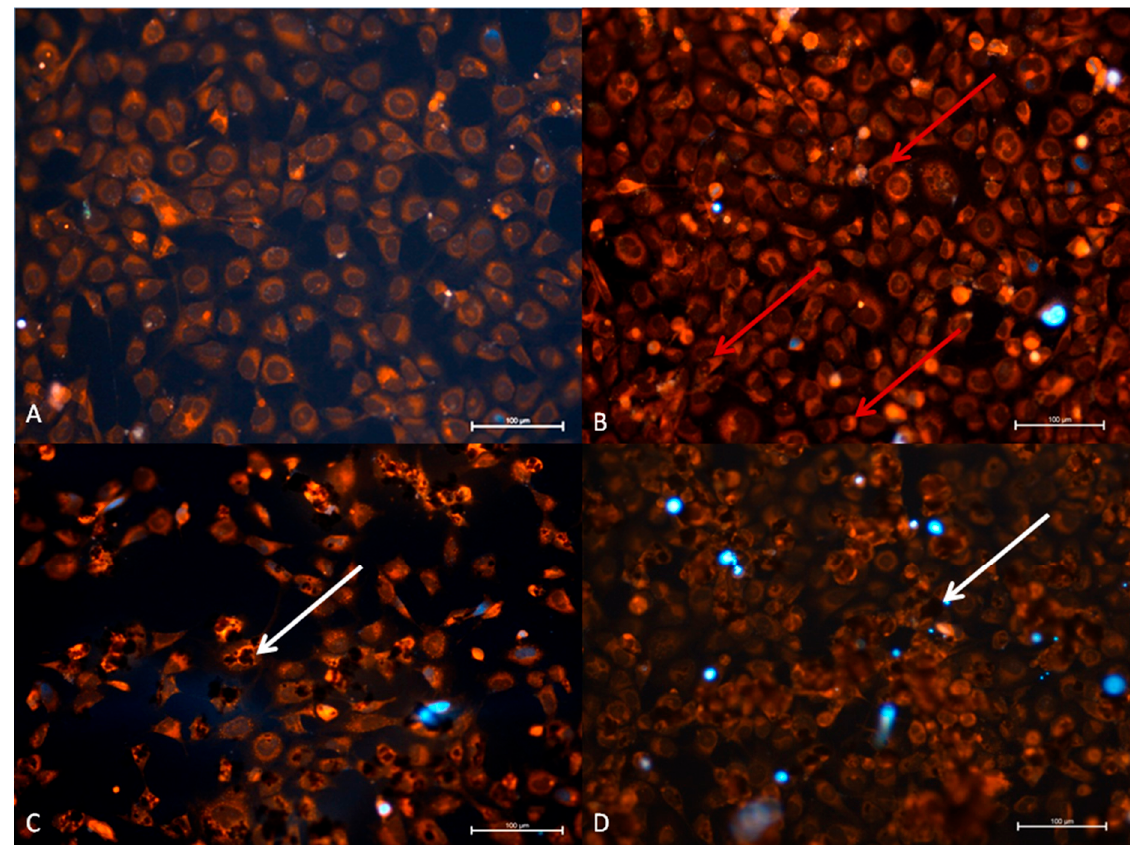
Figure 8. TC28a2 cell line 24 h after administration of virus and GO. ( A ) Control group, ( B ) RuVgroup, ( C ) GO group, ( D ) GO + RuV group. Mild cytopathic effect in cells with changed morphology (red arrow) after RuV administration is visible (red arrow).Visible graphene covering cells (white arrow) in both GO and GO + RuV treated cells. DAPI and Rhodamine B. Mag 100x. Scale bar 100 μ m.